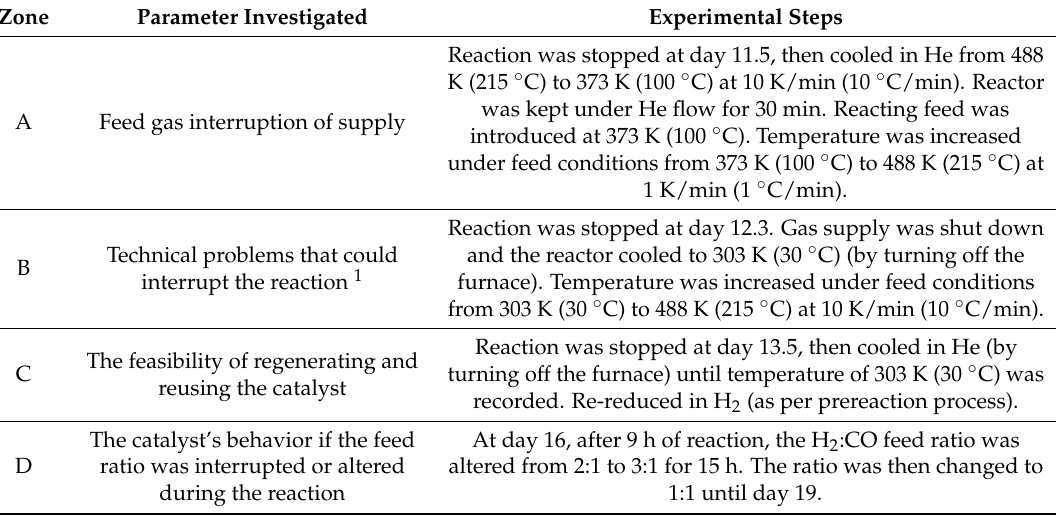
Table 4. Zones investigated in R4 for testing the system